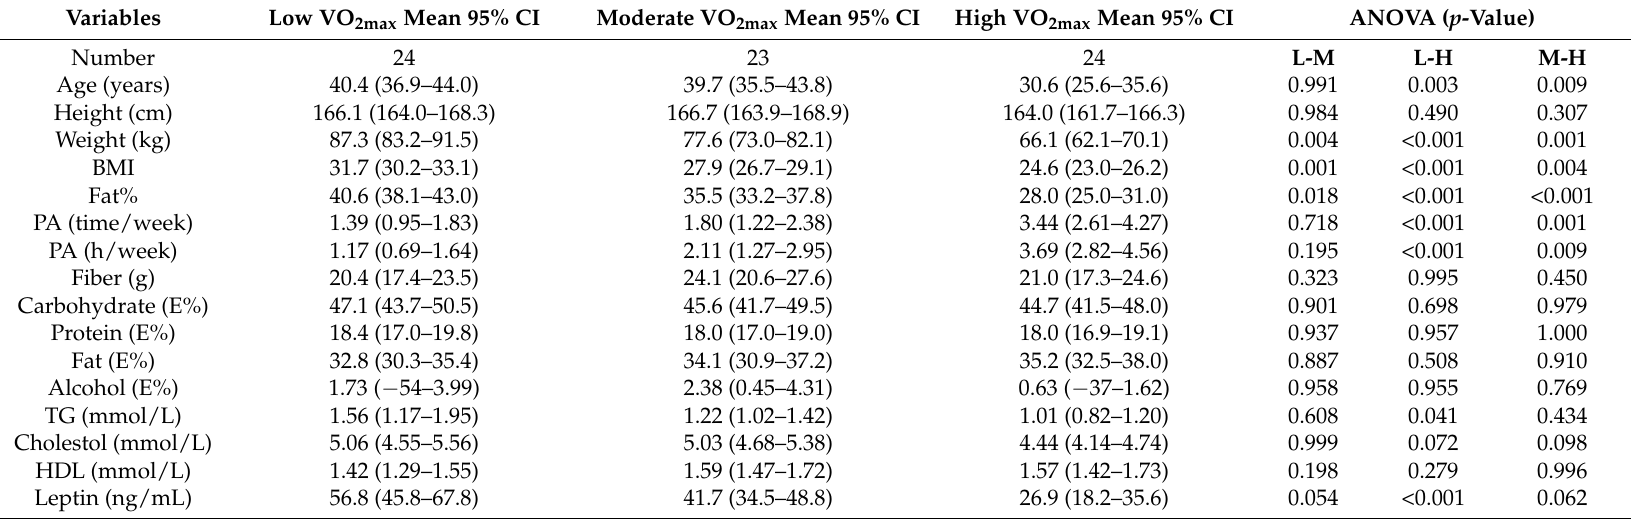
Table 1. Physical characteristics, background and gut microbiota composition in the low, moderate and high cardiorespiratory fitness groups (means with 95% confidence intervals are given and contrast estimates ( p -values) by multivariable comparison with Sidak to localize the significant differences between the